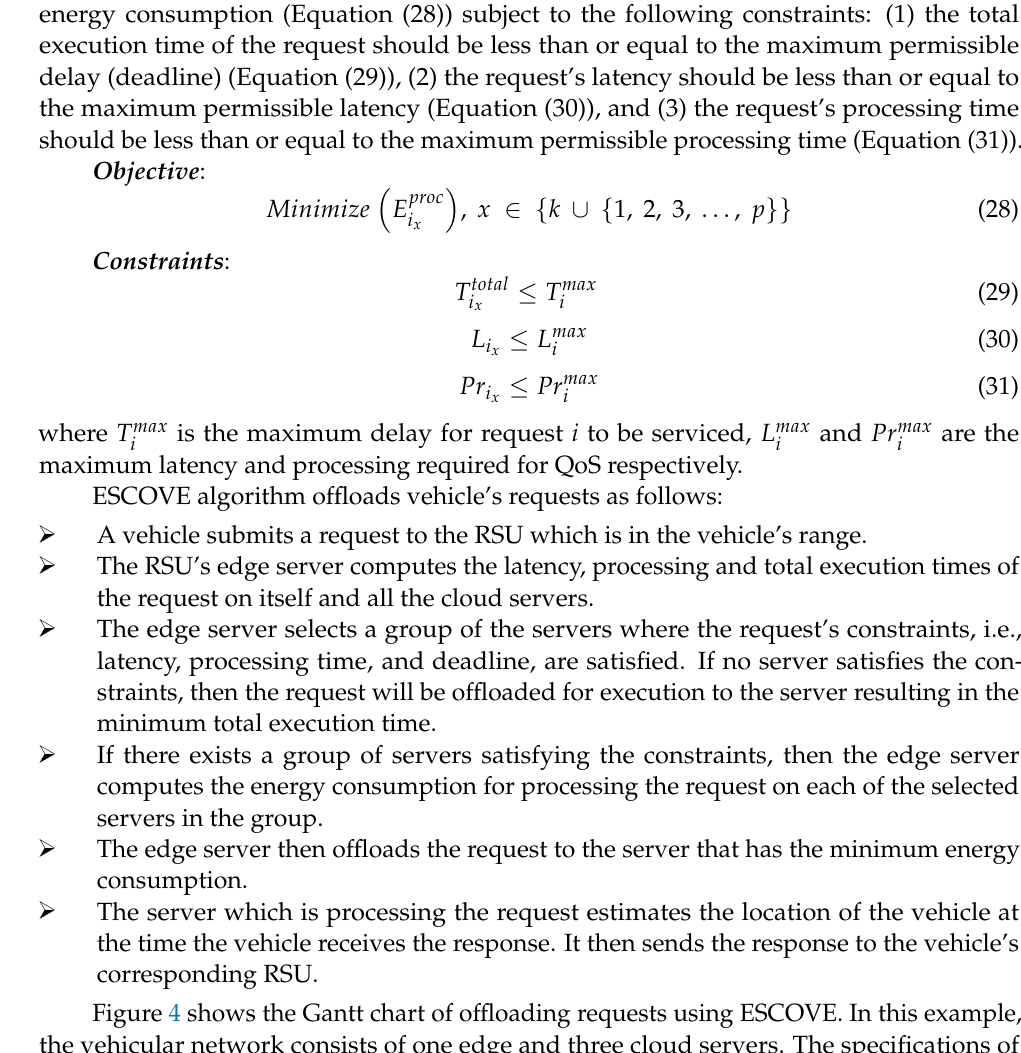
Table 1. Specifications of requests used in the example. Table 2. Power consumption values of requests on the edge and cloud servers used in the example.